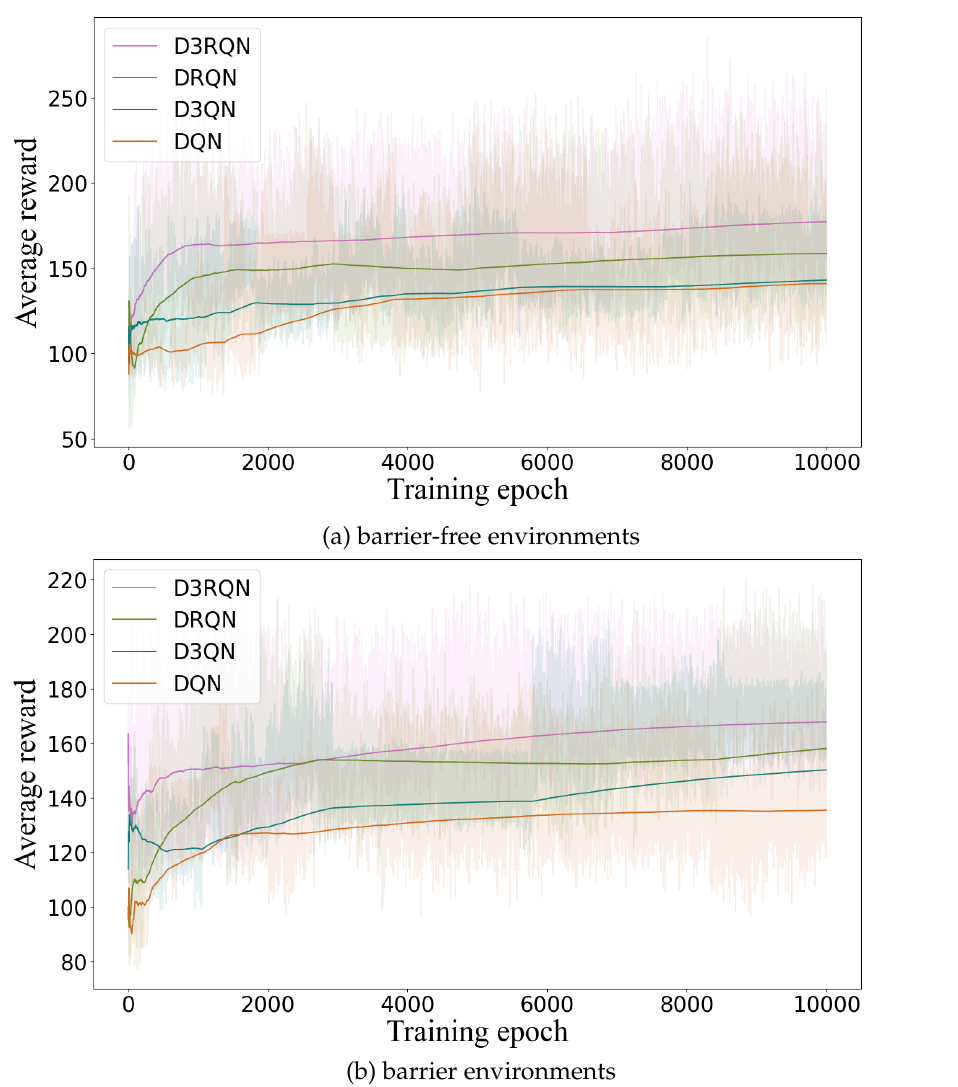
Figure 7. Comparison of the experimental results of five observation platforms. ( a , b ) Comparison of the reward functions of DQN, DRQN, D3QN, and D3RQN running in barrier and barrier-free environments,